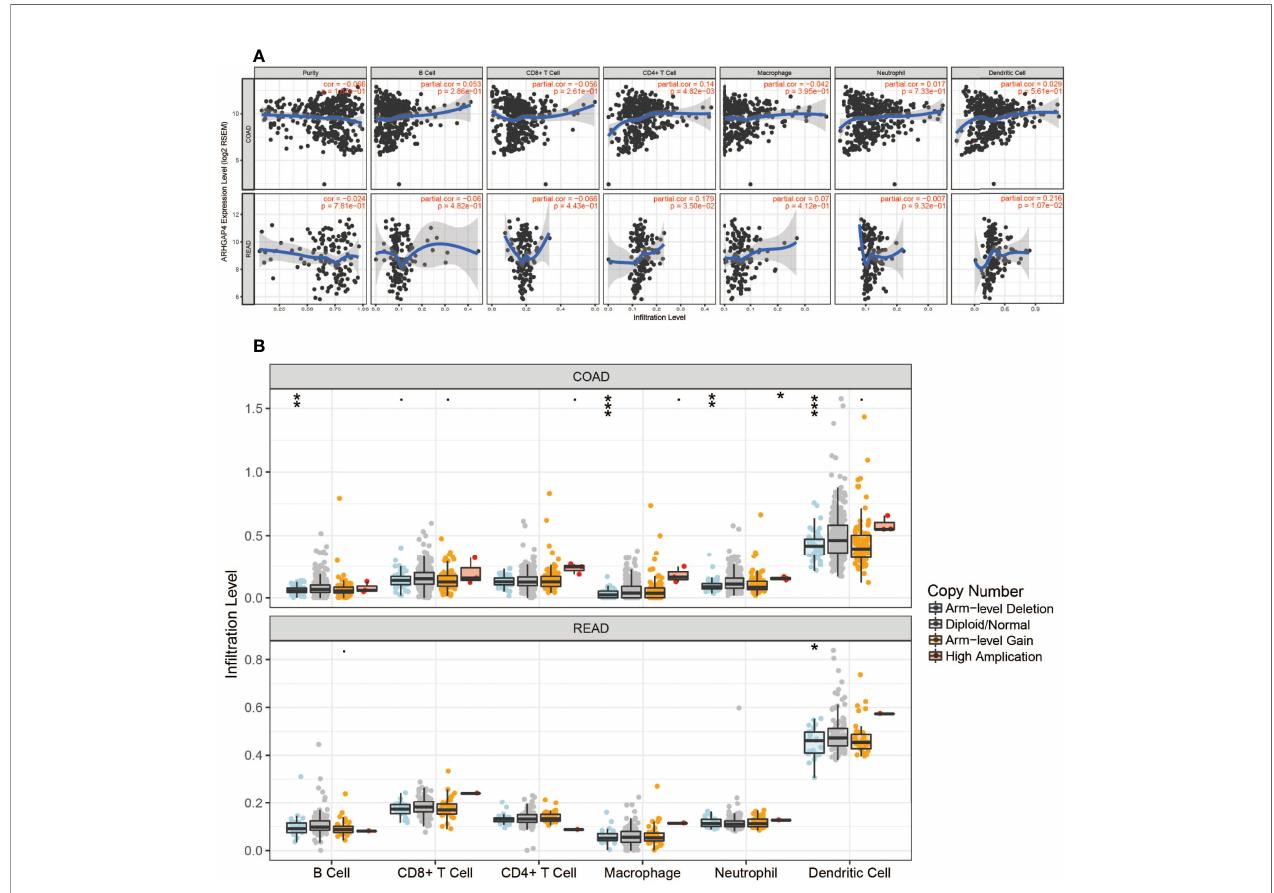
FIGURE 4 | ARHGAP4 gene and immune cells. (A) ARHGAP4 expression was highly correlated with CD4 + T-cell in fi ltration in CRC and dendritic cell in fi ltration in READ. (B) After ARHGAP4 gene knockout, the levels of B cells, macrophages, neutrophils, and dendritic cells are downregulated, after the high-ampli fi cation ARHGAP4 gene. The levels of CD8 + and CD4 + T cells, neutrophils, and dendritic cells are upregulated in COAD. *Indicates that the P value is less than 0.05, **Indicates that the P value is less than 0.01, ***Indicates that the P value is less than